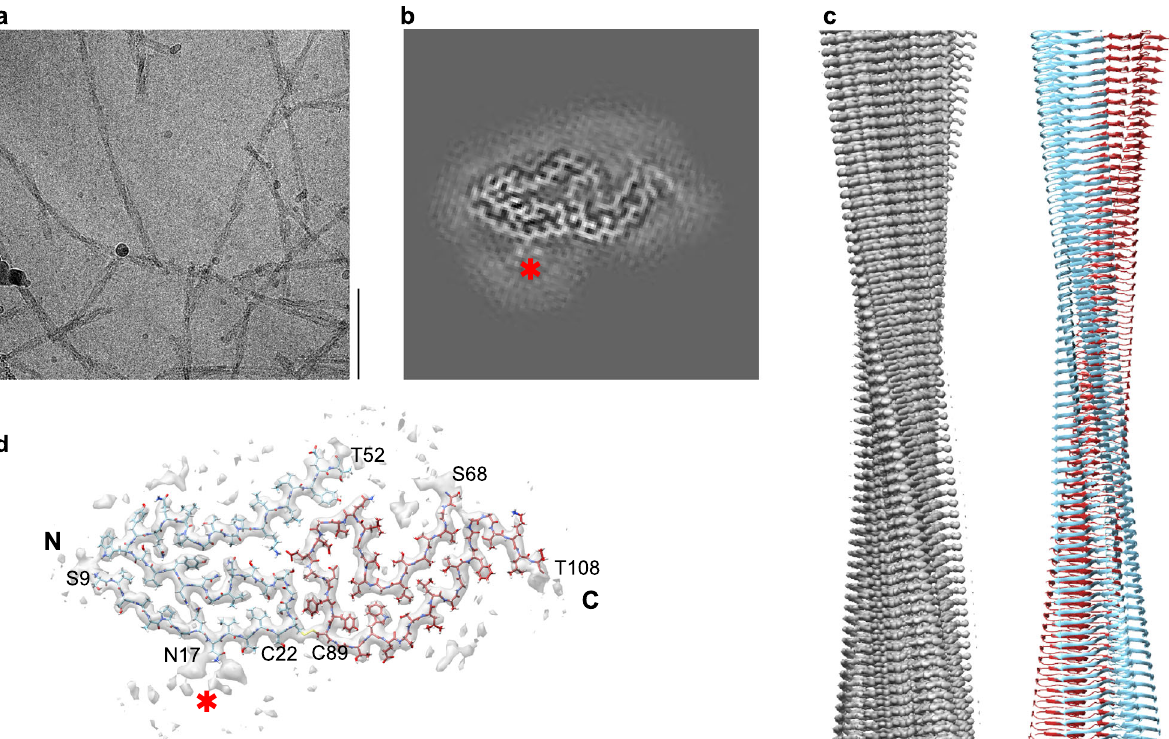
Fig. 2 Cryo-EM structure of the FOR001 AL amyloid fi bril. a Cryo-EM image of FOR001 amyloid fi brils. Scale bar is 100 nm. The dataset consists of 3033 micrographs. b Cross section of the map obtained by summing fi ve central slices. c Side view of the map (left) and molecular model (right), showing the left-handed fi bril twist. d Cross section of the map with the molecular model overlaid. The color coding of the model is the same in panels ( c ) and ( d ), that is, light blue refers to the N-terminal segment of the ordered fi bril protein (residues Ser9 – Thr52), while the deep-red segment refers to the C-terminal segment (residues Ser68 – Thr108). The two segments are cross-linked through a disul fi de between Cys22 and Cys89. The red star in ( b ) and ( d ) indicates the glycosylation site at Asn17.